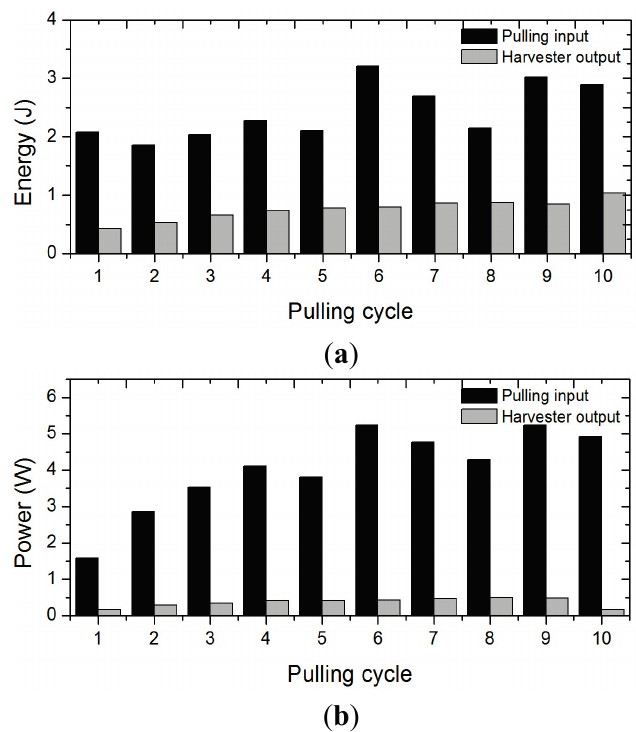
Figure 9. Mechanical pulling input and electrical output of all the cycles. ( a ) Energy; ( b )